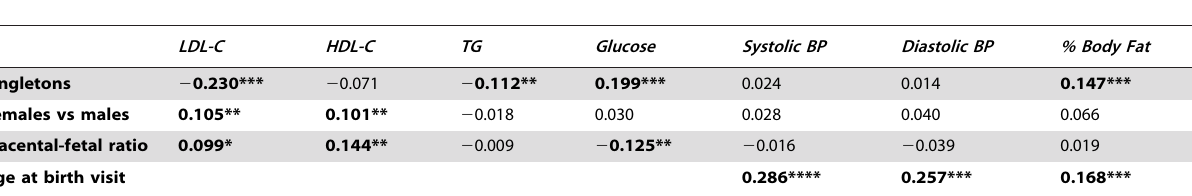
Table 5. Standardized Estimates in univariate analysis of key newborndeterminants, adjusted for gestational age of newborn at